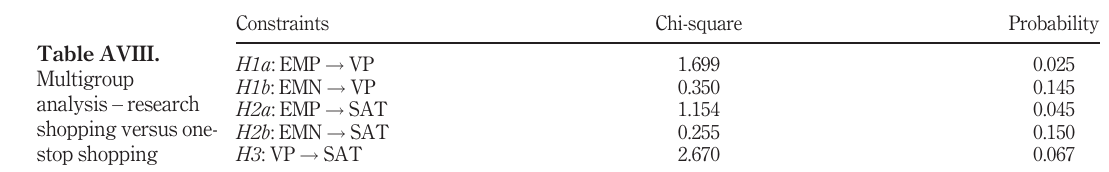
shopping versus one- stop shopping